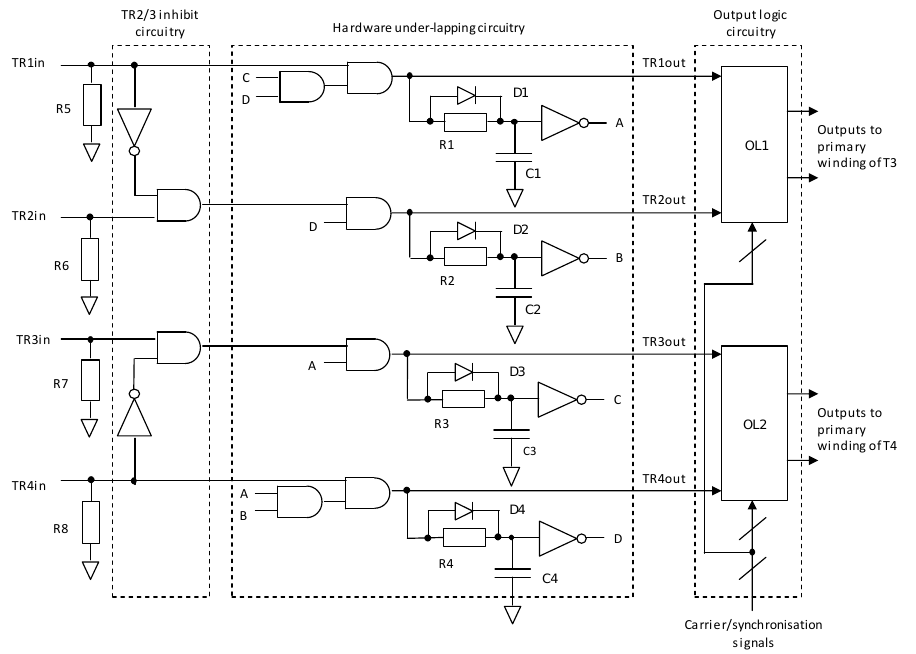
Figure 6. Low-side logic circuitry. The signal transformers are designated T3 and T4 in this figure as the power transformers have been designated T1 and T2.